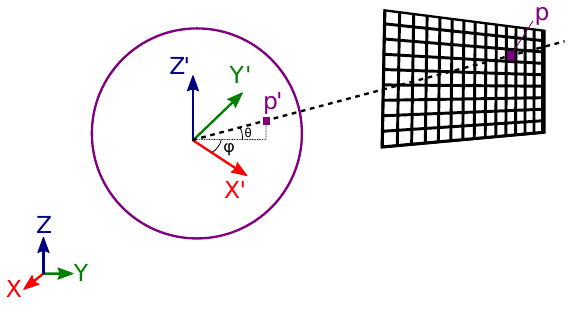
Figure 6: A rectangular patch in 3D space is sampled at a specific resolution, e.g. 1 pixel/mm. Each pixel p is transformed into the local coordinate frame ( X (cid:48) , Y (cid:48) , Z (cid:48) ) of the panoramic sphere in spherical coordinate angles azimuth φ and elevation θ to deter- mine the color value in the panoramic